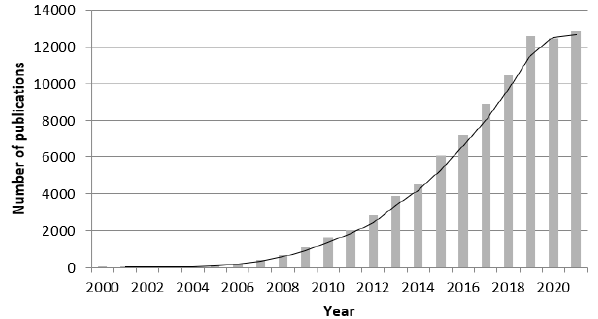
Figure 1. Number of publications with the keywords ‘Building Information Model(l)ing’ each year, in Google